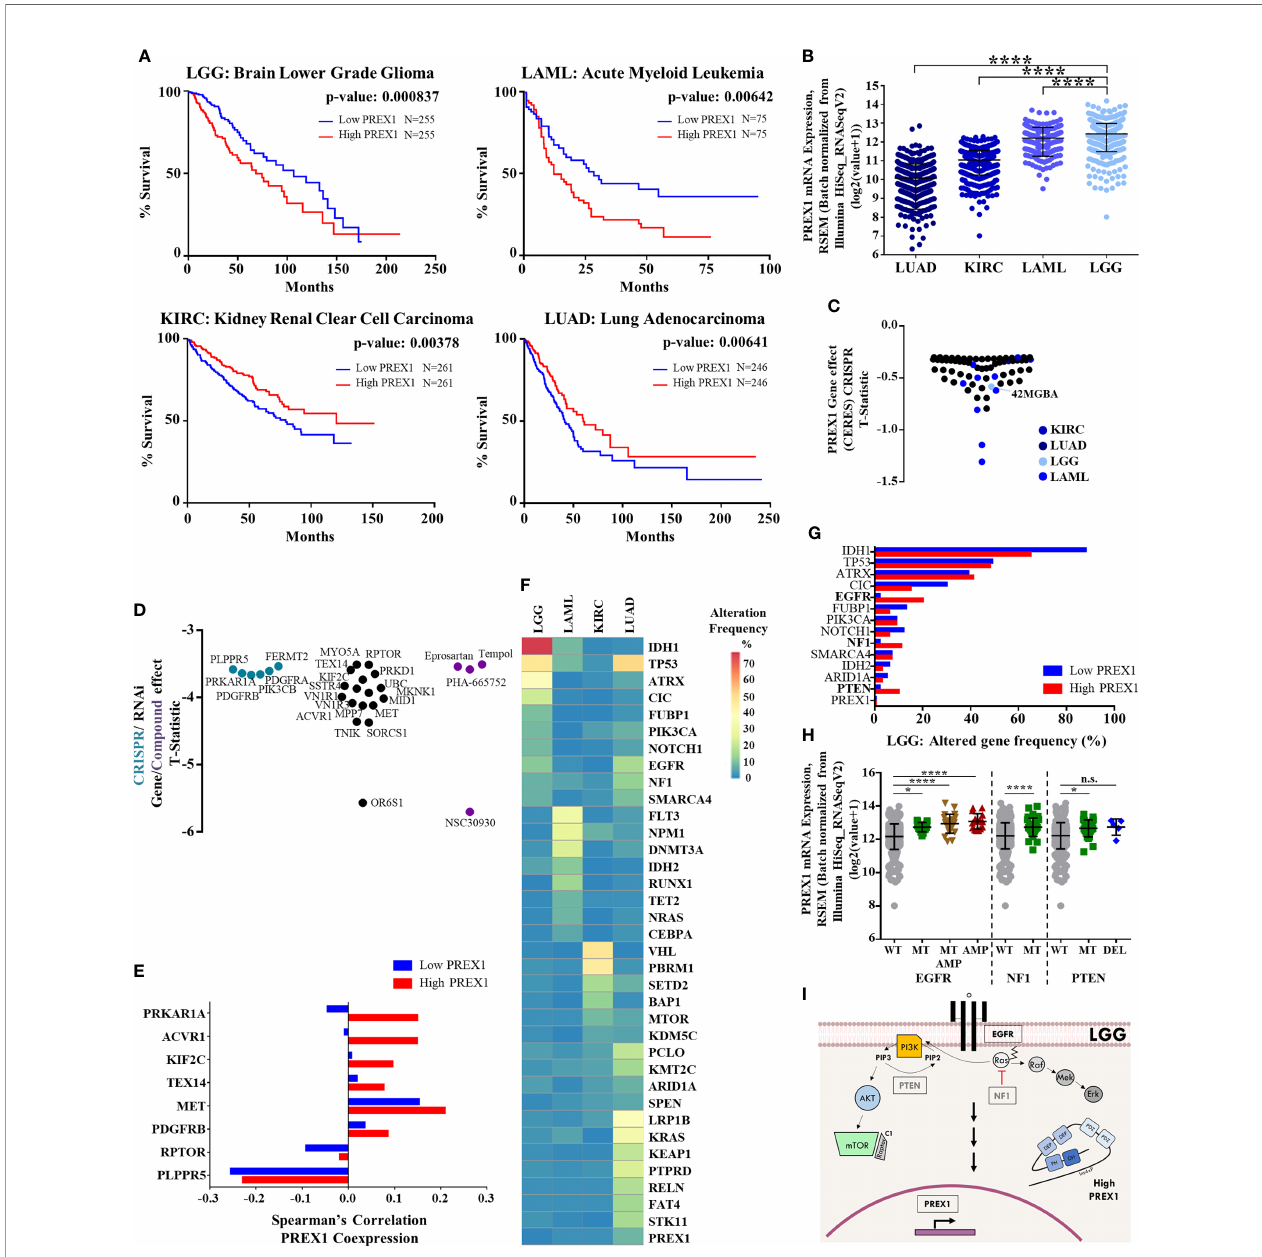
FIGURE 1 | High PREX1 expression correlates with shorter LGG patient survival. (A) High PREX1 expression assessed in TCGA datasets correlates with shorter overall survival of LGG, LAML, KIRC and LUAD patients. Tumors with highest and lowest PREX1 expression (50:50 percentiles) were compared. mRNA expression values [RSEM (Batch normalized from Illumina HiSeq_RNASeqV2)] were used for the analysis. Statistical p values were calculated using the Log-rank test. (B) Comparative analysis of PREX1 mRNA expression (RNAseq) among LGG, LAML, KIRC and LUAD tumors, with data from TCGA studies obtained from the cBioPortal platform. Error bars represent mean ± SD. ****p < 0.0001, one way ANOVA followed Tukey. (C) PREX1 dependent cell lines analyzed in the DepMap portal representing LGG, LAML, KIRC and LUAD cancer types. Graph shows T-statistic values. Different tones of blue were assigned to cell lines corresponding to each cancer type. (D) Astrocytoma dependencies revealed by CrisprCas9 (blue green), RNAi (black), and small molecules (purple) targeting the signaling repertoire. Effects are displayed as T-statistic values from the DepMap platform. (E) Coexpression of PREX1 and selected essential signaling proteins, identi fi ed in cell lines within the astrocytoma context [shown in (D) ], was compared between low and high PREX1 -expressing LGG tumors of the TCGA transcriptomic dataset. (F) Comparative mutational signature of the top ten altered genes in LGG, LAML, KIRC and LUAD tumors. Scale shows percent of alteration. (G) Top ten frequencies of altered genes in LGG tumors with low and high PREX1 expression. Genes with higher alteration frequency in tumors with high PREX1 expression are highlighted in bold fonts. (H) PREX1 expression in LGG tumors with wild type (WT), mutated (MT) and/or ampli fi ed (AMP) EGFR, NF1 and PTEN genes. EGFR *p < 0.05, ****p < 0.0001, one way ANOVA followed Tukey. NF1 . ****p < 0.0001, t test. PTEN . *p < 0.05, one way ANOVA followed Tukey. n.s., non-signi fi cant. (I) Model showing canonical EGFR, NF1 and PTEN signaling pathways and their putative impact on PREX1